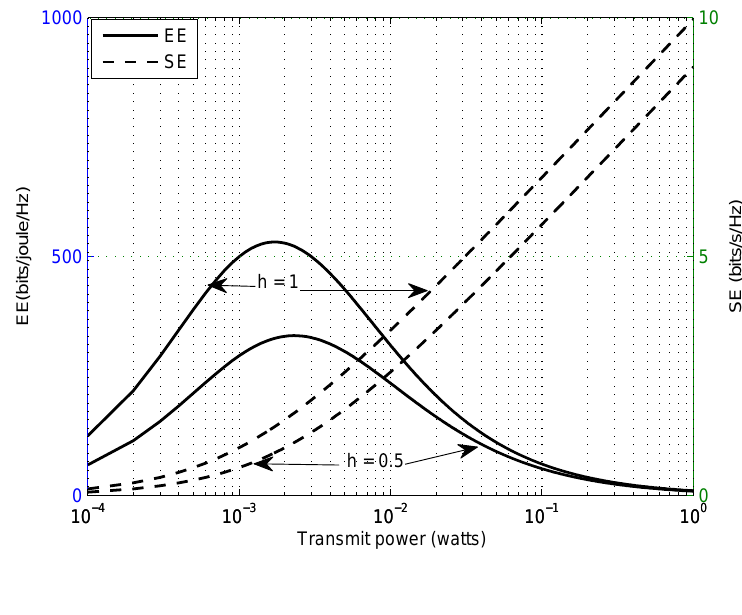
Figure 2. Plots for energy efficiency (EE) and spectral efficiency (SE) as a function of transmitted